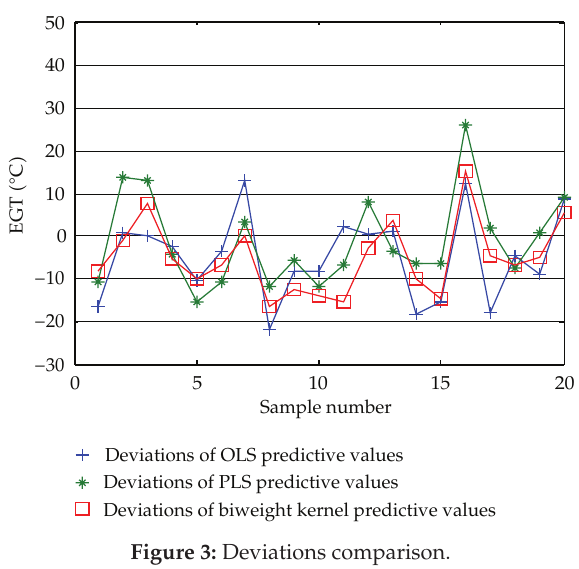
Figure 3: Deviations comparison.